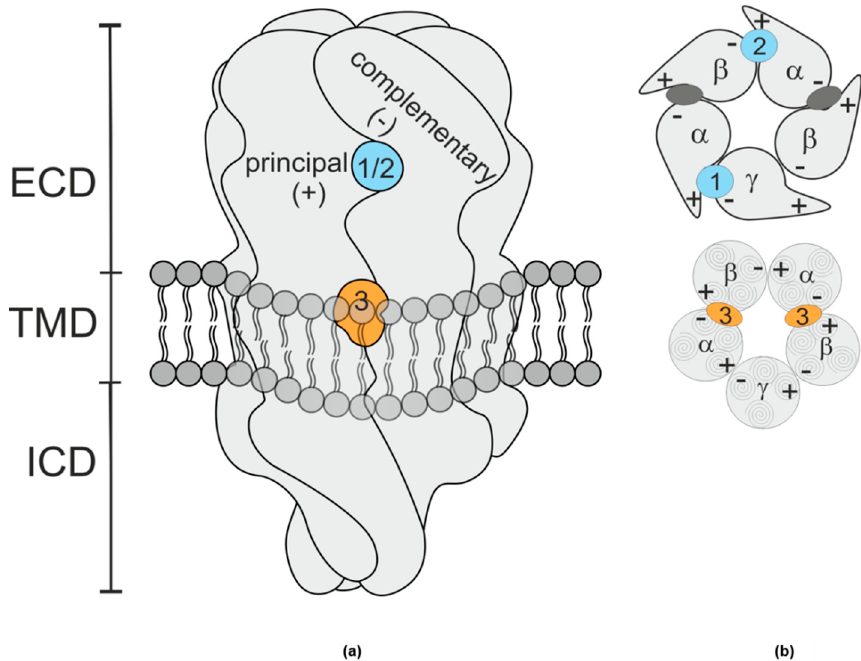
Figure 1. ( a ) Schematic rendering of a GABA A receptor. The extracellular domain (ECD) and transmembrane domain (TMD) contain various binding sites [11]. The binding sites studied in this work are at interfaces formed by a principal ( + ) subunit face and a complementary ( − ) subunit face. The shape resembles vaguely a space filling rendering of the protein’s ECD and TMD, while intracellular domain (ICD) shape is a purely schematic rendering based on more remote homologues. ( b ) Schematic planes through the ECD (top) and TMD (bottom) of a canonical αβγ receptor, the GABA sites are indicated as dark grey ellipses. Site 1 (blue), the high a ffi nity benzodiazepine site, is at the ECD– α +/ γ − interface; site 2 (blue), which confers modulatory e ff ects of pyrazoloquinolinone ligands is at the ECD– α +/ β − interface, and site 3 (orange), the etomidate site [7] occurs twice and is located at the TMD– β +/ α − interfaces below the GABA binding sites.